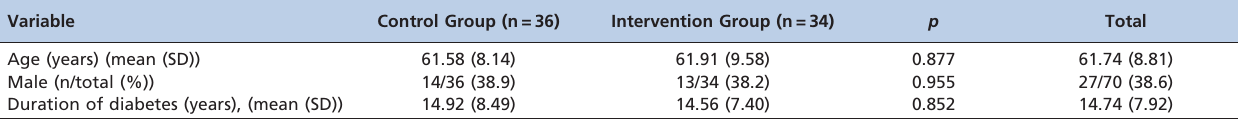
Table 1 - Baseline demographics of the study participants.